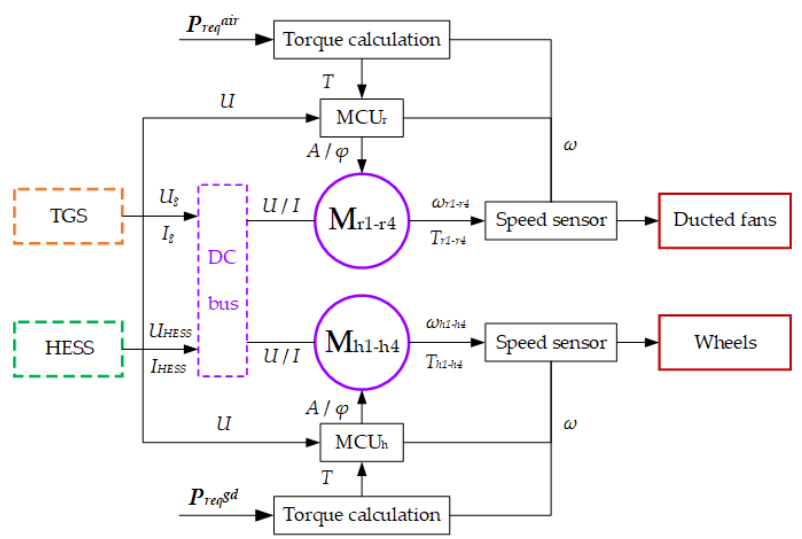
Figure 6. Configuration of distributed electric drive-propulsion